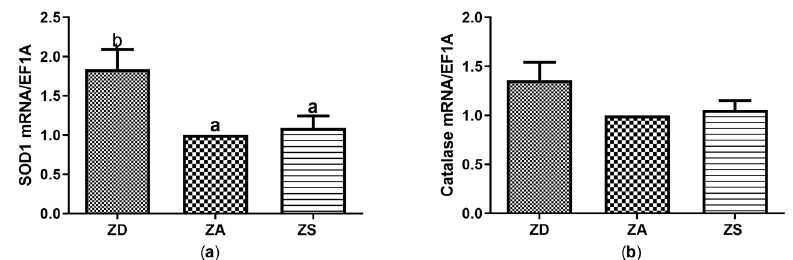
Figure 4. SF cells were cultured in CHELEX-treated medium, zinc adequate (ZA) medium or me- dium supplemented with zinc (50 µM) for 7 days. Afterwards mRNA was isolated, used for meas- uring expression of SOD1 ( a ) and Catalase ( b ) mRNA expression and normalized to EF1A mRNA. Mean values + S.E.M. of n = 7 independent experiments are shown. Significantly different data sets as determined by one-way Anova and Tukey’s post hoc test do not share the same letters ( p < 0.05).